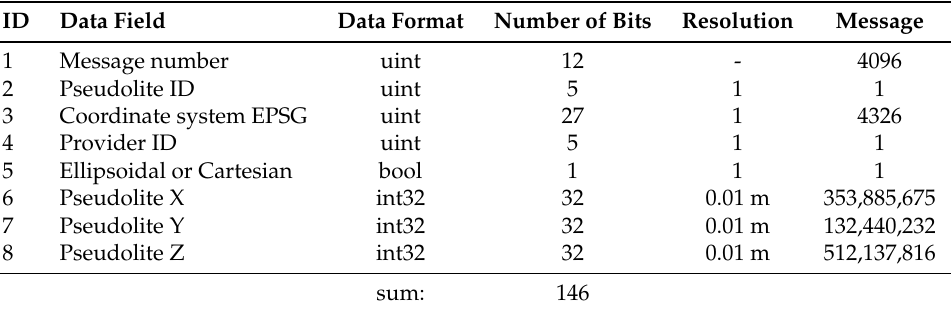
Table 8. Sample pseudolite specific part of designed RTCM